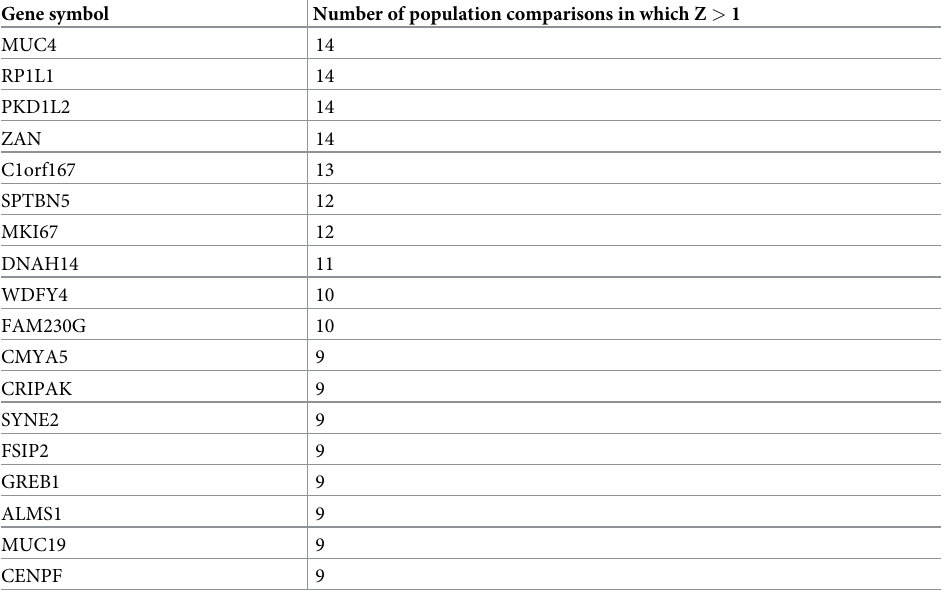
Table 7. Single gene analysis. Genes with Z > 1 in multiple population comparisons. Code to extract and analyse the data can be found at